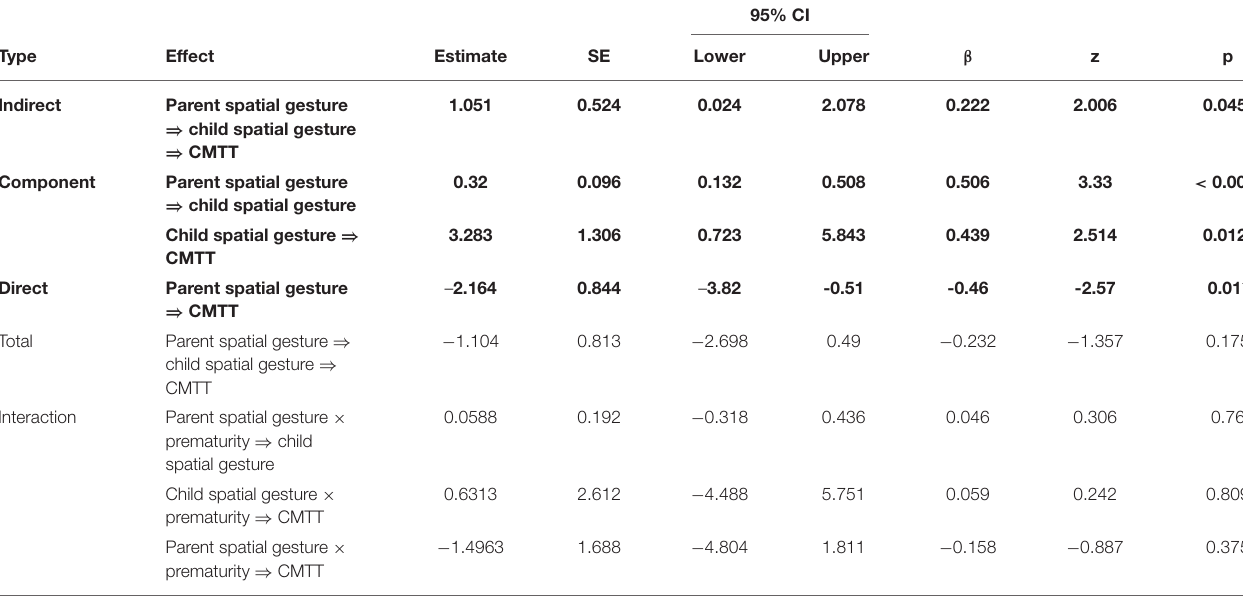
TABLE 7 | Mediation models for spatial gesture: effects that are statistically significant are written in